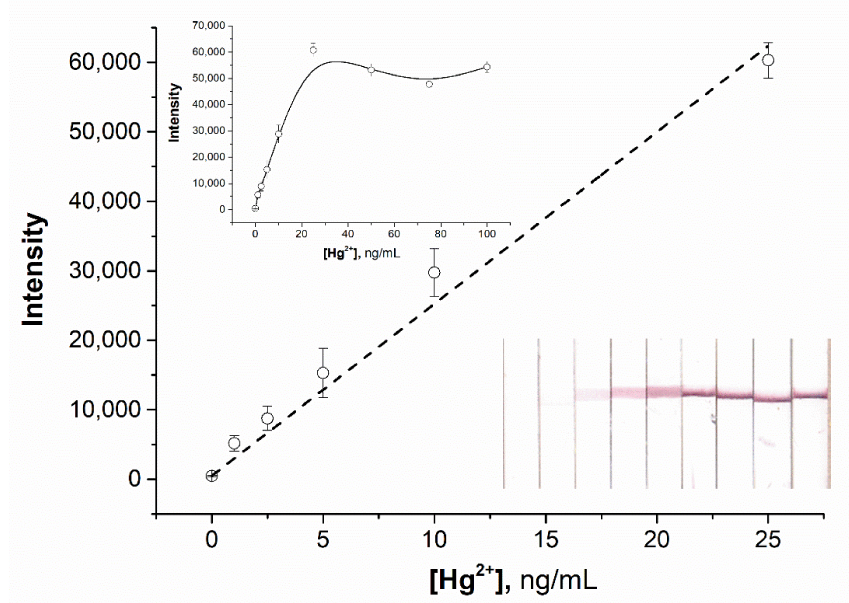
Figure 8. The linear range of the calibration curve for the determination of Hg 2+ by lateral flow test. Inserts : Calibration curve of Hg 2+ in the range of concentration 0–100 ng/mL ( above ) and a photo of lateral flow test strips after the detection of Hg 2+ ( below ). Error bars show the standard deviation from three replicate measurements. Table 1. Comparison of membrane-based point-of-use techniques for Hg 2+ detection in water. Method